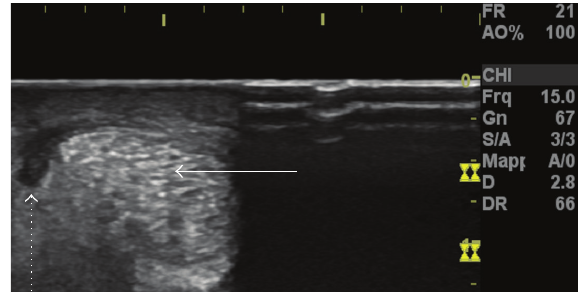
Figure 5: High resolution cross-sectional ultrasound of the Achilles tendon suffering from acute paratendinopathy. Laterally to the body of the Achilles tendon ( filled arrow ), a hypoechoic area is visible ( dotted arrow ), which is compatible with fluid collection between the tendon and the